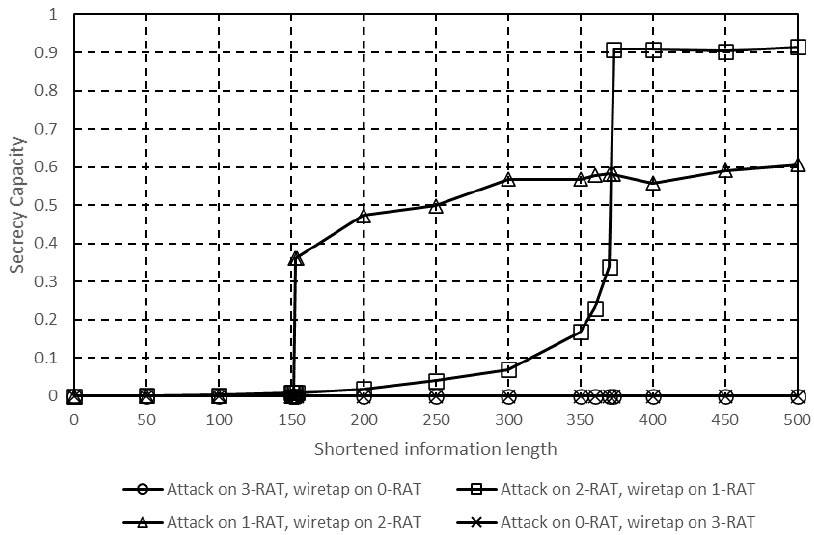
Figure 12. Characteristics of the mutual information versus the shortened information length when the sender and the receiver communicate using three RATs. The circle marks and the square marks indicate the mutual information between the sender and receiver when two and one RAT(s) cannot be used for communication due to an attack, respectively. The triangle marks and the cross marks indicate the mutual information between the sender and the cyberterrorist when two and one RAT(s) are / is wiretapped, respectively.